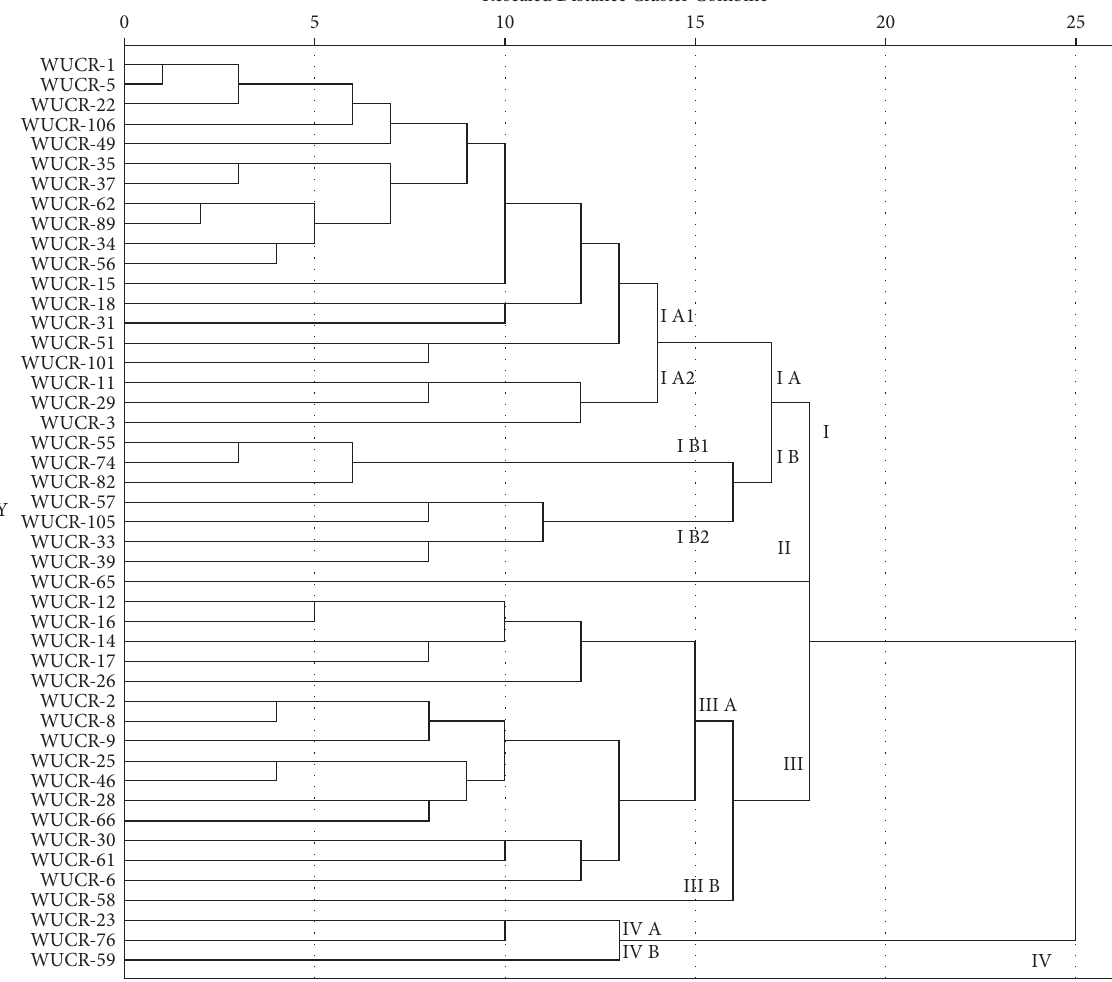
Figure 11: A Dendrogram highlighting the phenotypic diversity of chickpea rhizobial